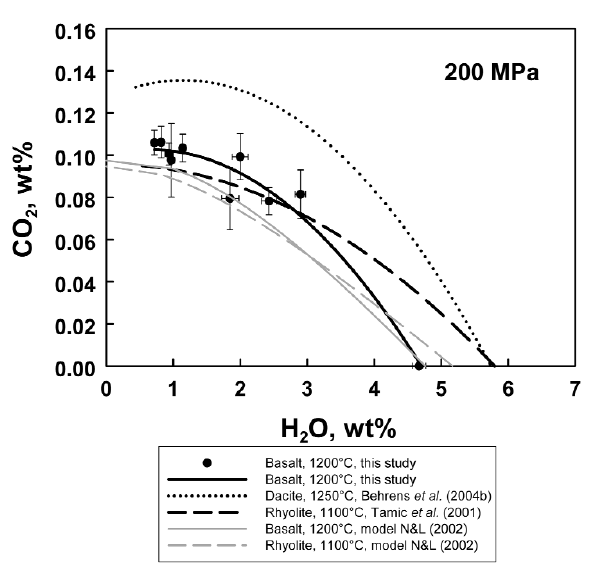
Fig. 4. The effect of silicate melt composition on solubilities of water and carbon dioxide at 200 MPa in the temperature range 1100-1250°C. The black lines are the best polynomial (2nd order) fits of experimental data. Basalt composition (SC1, see table A.I. in Appendix A) was investigated at 1200°C and MnO-Mn 3 O 4 oxygen buffer (to vary mole fraction of H 2 O in the fluid phase, CO 2 was added as silver oxalate source, Ag 2 C 2 O 4 ). The description of experimental and analytical technique is presented in the Appendix A. Gray lines are modeled sol- ubilities for rhyolite and basalt after Newman and Lowenstern